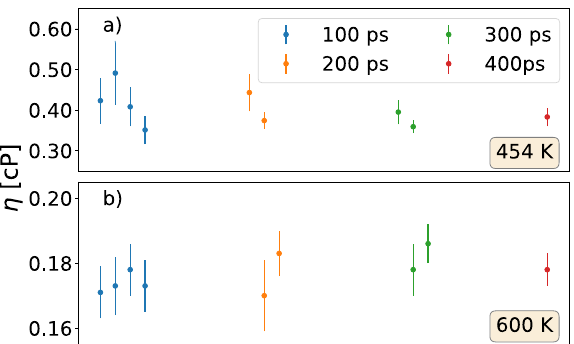
Fig. 2 η vs. length of the simulation. Dependency of the shear viscosity η on the length of the simulation, estimated by AIMD a at 454 K and b 600 K. Different colors refer to different simulation times. Error bars represent standard deviations.